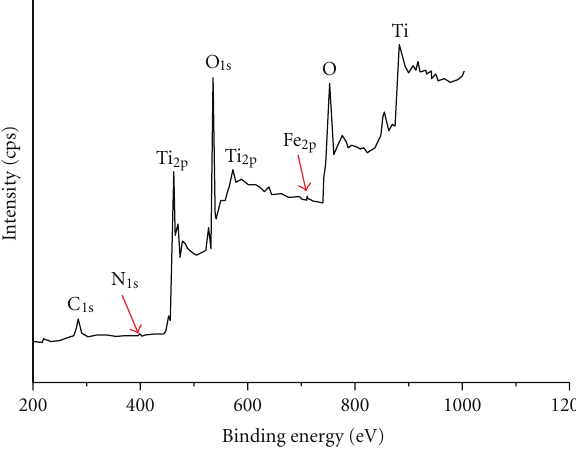
Figure 4: The XPS spectra of 2wt% Fe-N-TiO 2 nanocomposites calcined at 400 ◦ C.